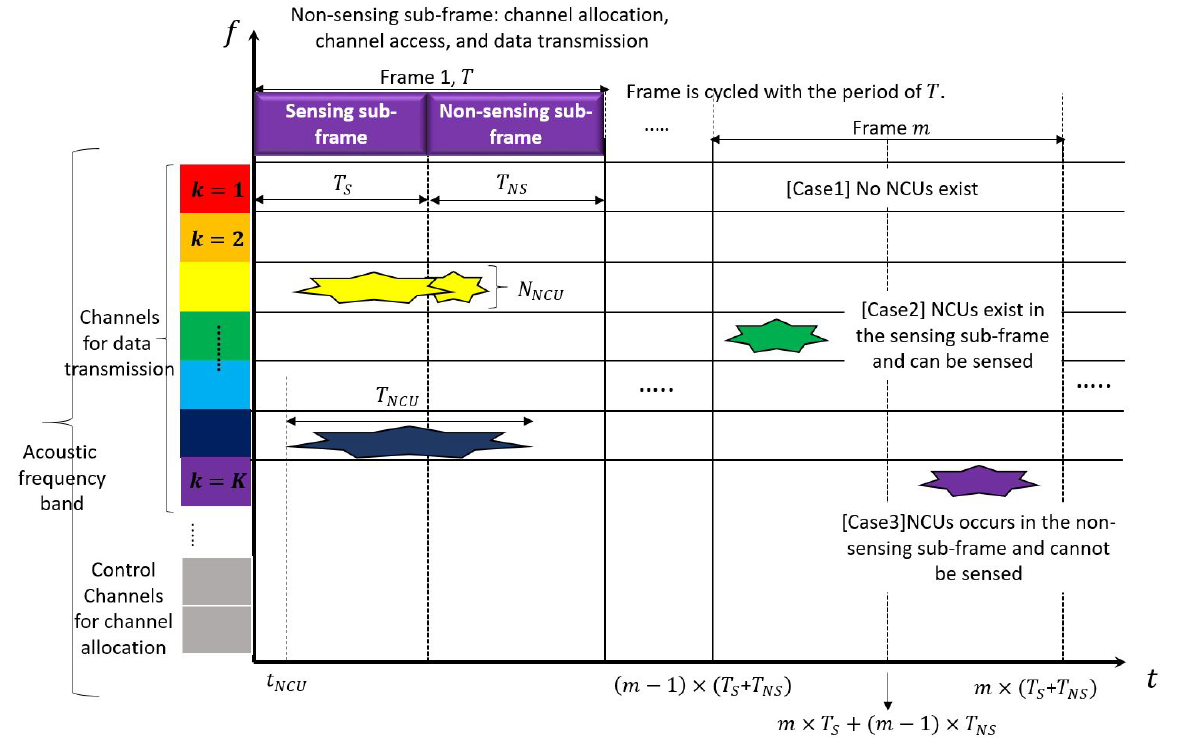
Figure 2. An illustration of the fragmentation in both time and frequency